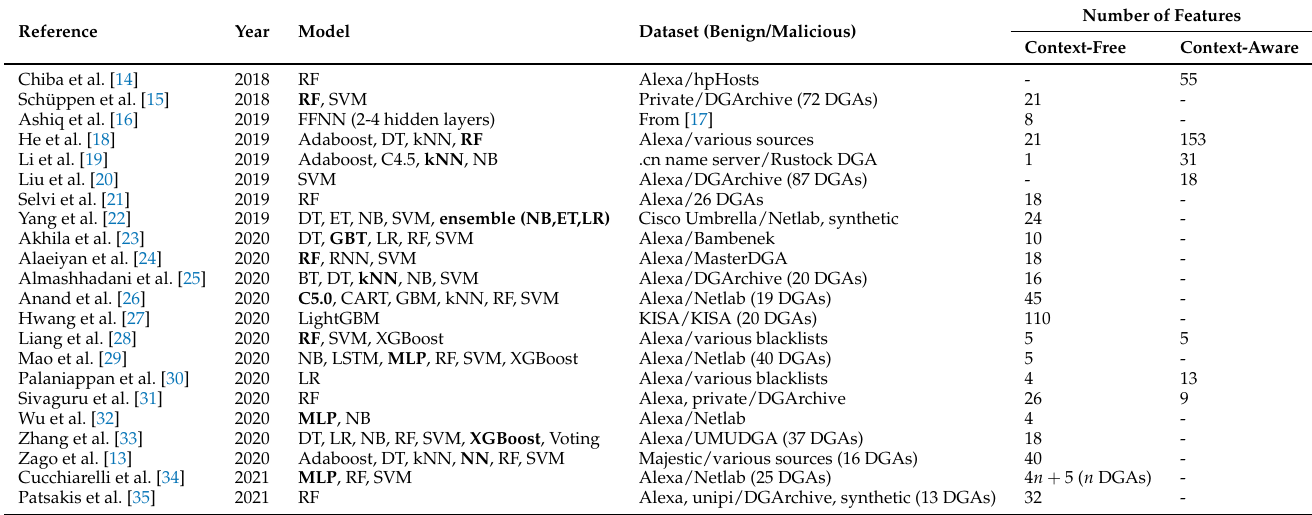
Table 1. DGA-based botnet detection using feature-based ML